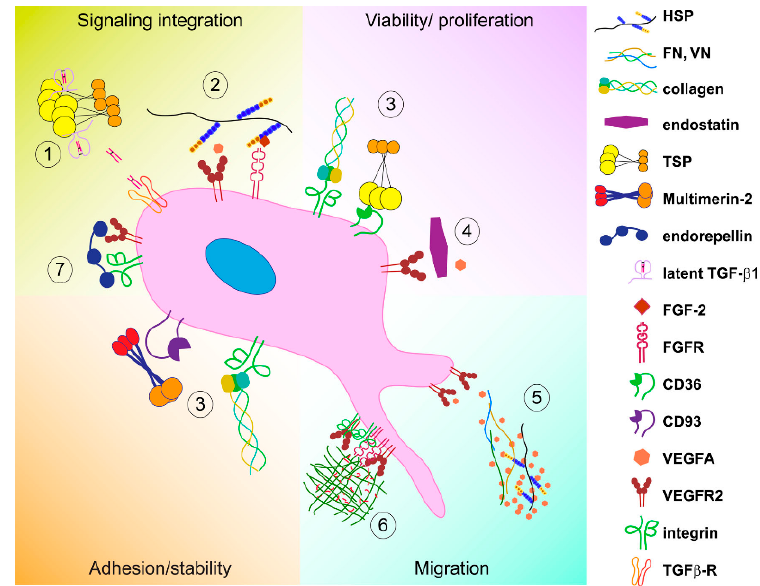
Figure 2. Schematic representation of the major mechanisms by which ECM affects endothelial cell function. The ECM impacts on EC function via these major mechanisms: ( 1 ) Acting as a modulator of growth factors’ maturation, ( 2 ) displaying multiple binding sites for different growth factors within the same molecule, thus contributing to receptor clustering and signaling network, ( 3 ) affecting EC viability and proliferation, engaging cell surface receptors, ( 4 ) acting as stumbling block for the ligand/receptor interaction, ( 5 ) regulating the spatio-temporal growth factors’ availability, ( 6 ) serving as mechanotransducers, and ( 7 ) simultaneous binding of different receptors and modulating of their trafficking.